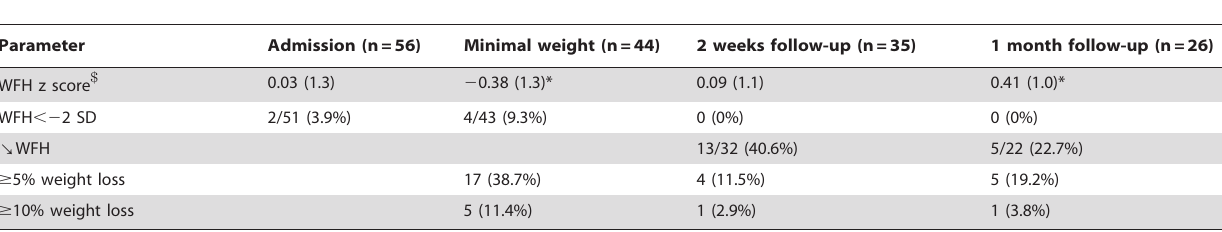
Table 2. Nutritional status during hospitalization and at outpatient